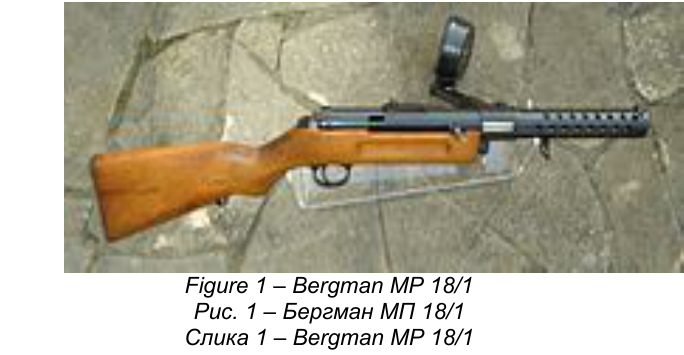
Figure 1 – Bergman MP 18/1 Рис . 1 – Бергман МП 18/1 Слика 1 – Bergman MP